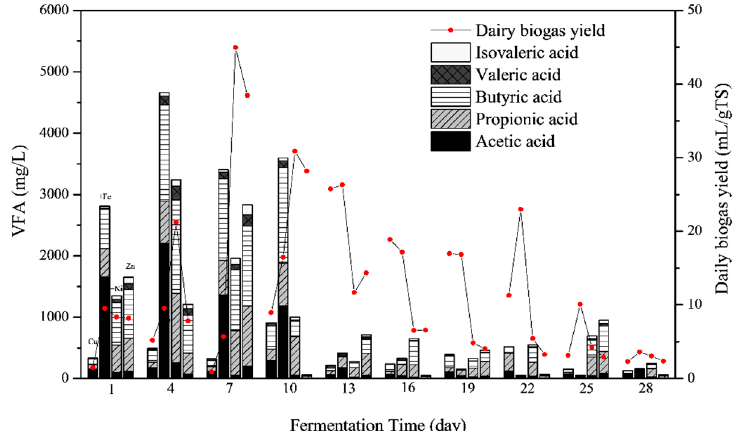
Figure 4. Volatile fatty acids (VFAs) concentrations in the liquid phase during the fermentation process. For each day, the column from left to right shows the VFA compositions of Cu, Cu + Fe, Cu + Ni and Cu + Zn treatments, respectively. The compositions of VFA were shown by stacked bars in the order of acetic acid (black), propionic acid (bias), butyric acid (transverse) and valeric acid (grid) from